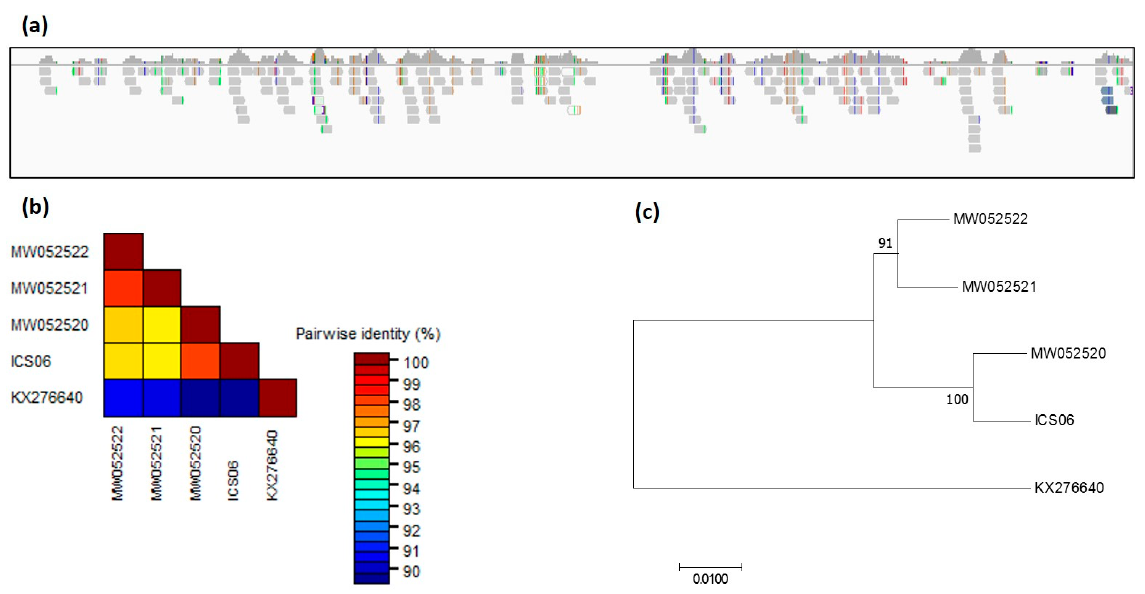
Figure 7. Genome coverage and phylogeny. ( a ) Sequence reads mapped to reference genome (GenBank accession KX276640) of cacao mild mosaic virus (CaMMV) from ICS 6 isolate identified in dataset SRR377712. ( b ) Genetic distances and ( c ) phylogenetic relationship among ICS 6 isolate and CaMMV isolate SCA 06 identified in Trinidad (GenBank accessions KX276640), PR3 isolate discovered in Puerto Rico (GenBank accessions MW052520), and Brazilian isolates BR321 and BR322 (GenBank accessions MW052521, MW052522).